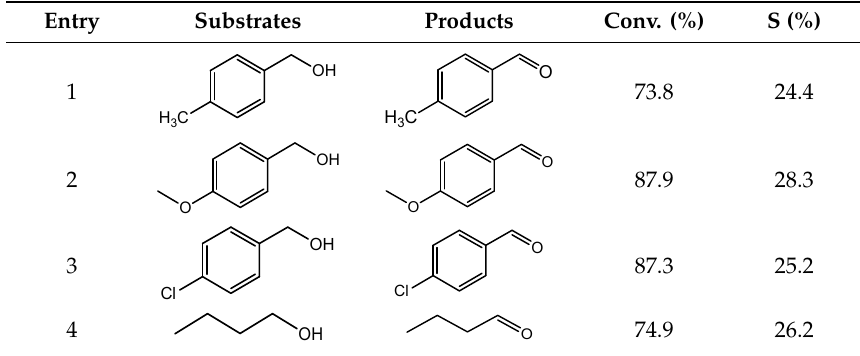
Table 3. Catalytic activities of CuNi/MIL-101 for the oxidation of various alcohols 1. Entry Substrates Products Conv. (%) S (%)